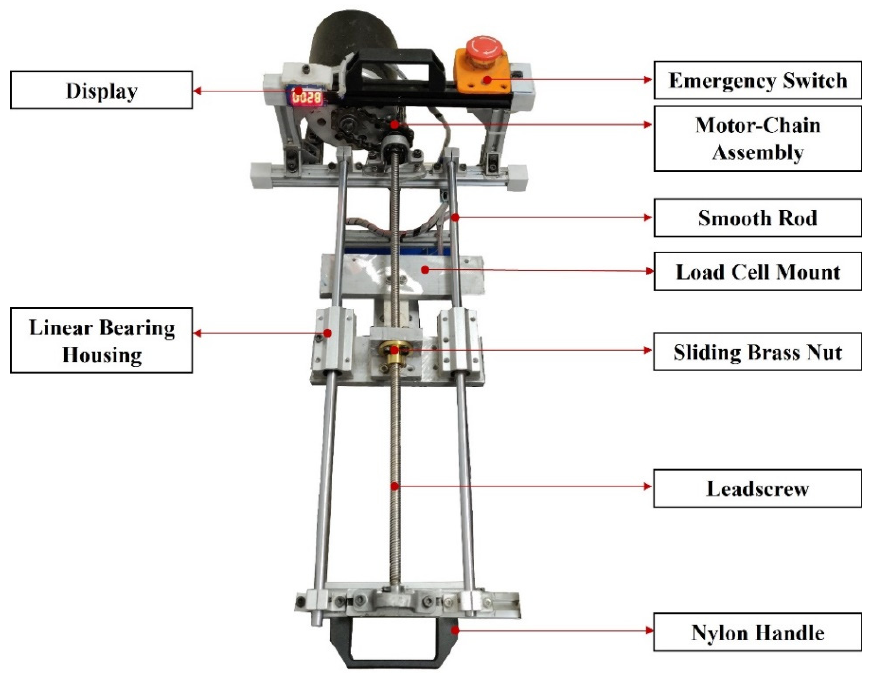
Figure 2. Horizontal motion assembly.